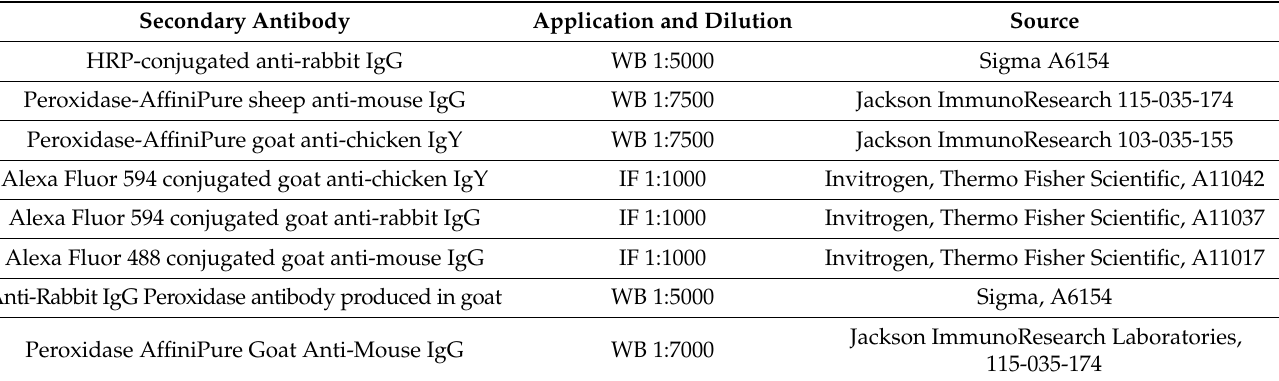
Table 2. List of secondary antibodies used in Western blot and